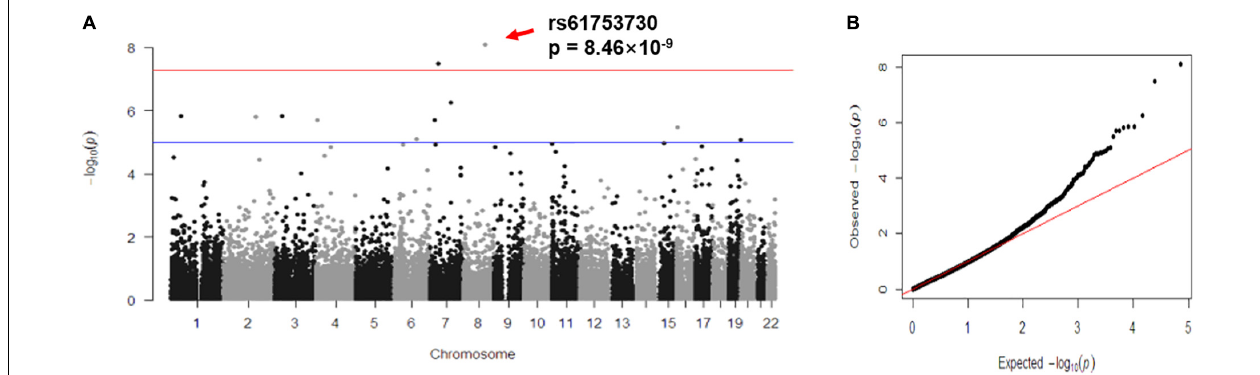
FIGURE 1 | Genetic findings of rs61753730 in FZD6 associated with depressive symptoms. (A) Manhattan plot of all results from exome-wide association study (EWAS) for CES-D score according to chromosome location. (B) Quantile–quantile plot of observed vs. expected –log 10 ( p -value) of SNPs from EWAS. λ , genomic inflation factor, estimated at close to 1. Red arrow indicates the location of